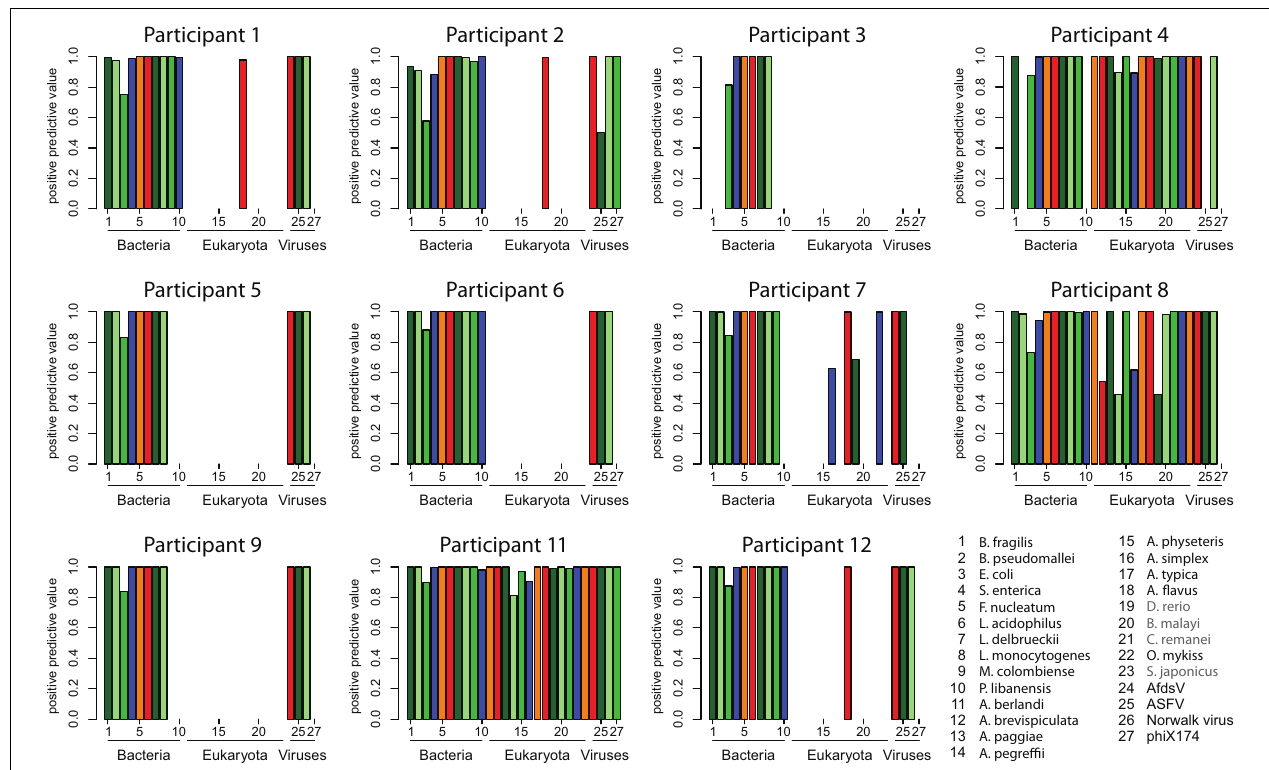
FIGURE 2 | Positive predictive values of read assignments calculated from the complete read set, calculated based on the species assignments. Sequences of the taxa labeled gray ( Brugia malayi , Caenorhabditis remanei , Danio rerio , and Scomber japonicus ) were downloaded unintentionally as part of the Anisakis sequence